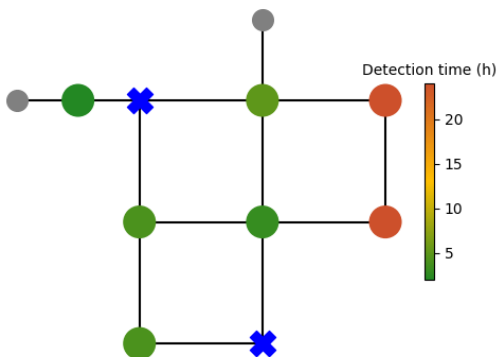
Figure 8. The objective space considering Hanoi network using algorithm A1 ( a ) and A2 ( b ). True Pareto front in red. Lighter colors denote later iterations.